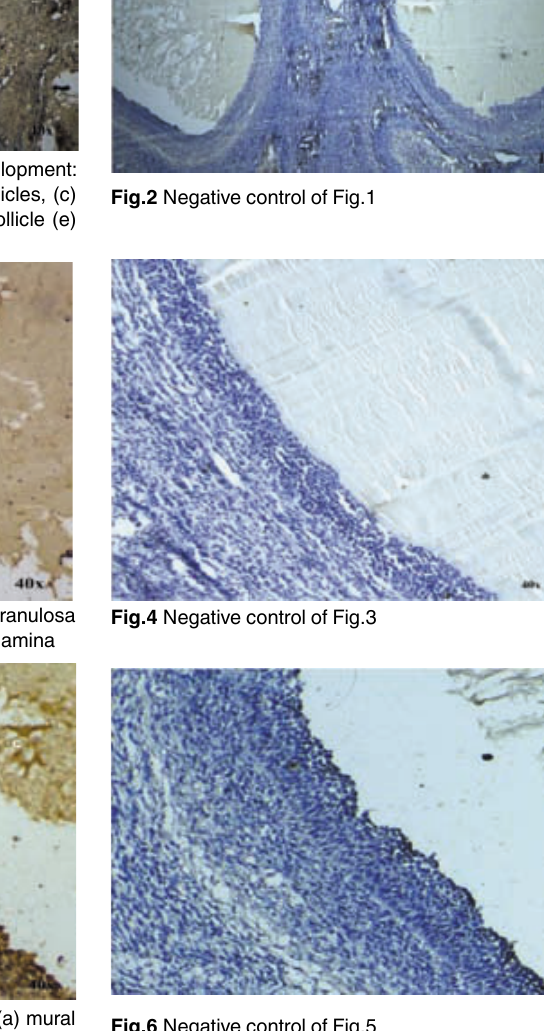
Fig.5 Ang-2 expression Magnified version (a) mural granulosa cells, (b) theca interna cells of antral follicle (c) follicular fluid